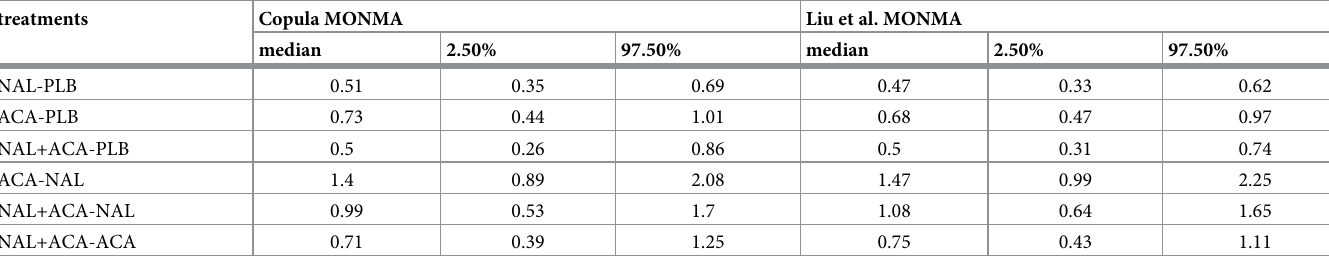
Table 5. Return to heavy drinking: Pooled effects posterior median and HPD 95% credibility